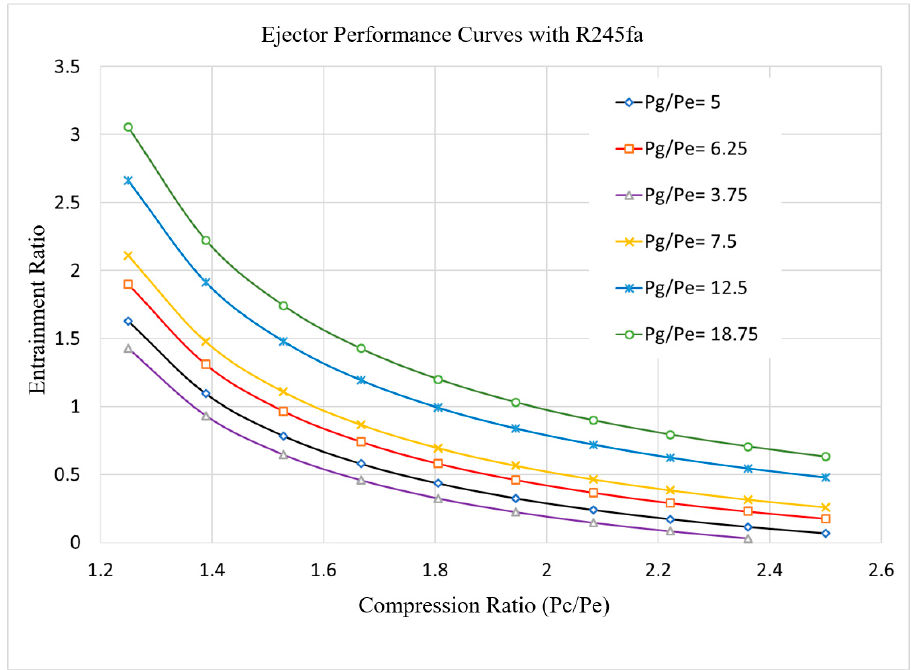
Figure 14. R245fa-Performance curves for Ejector.